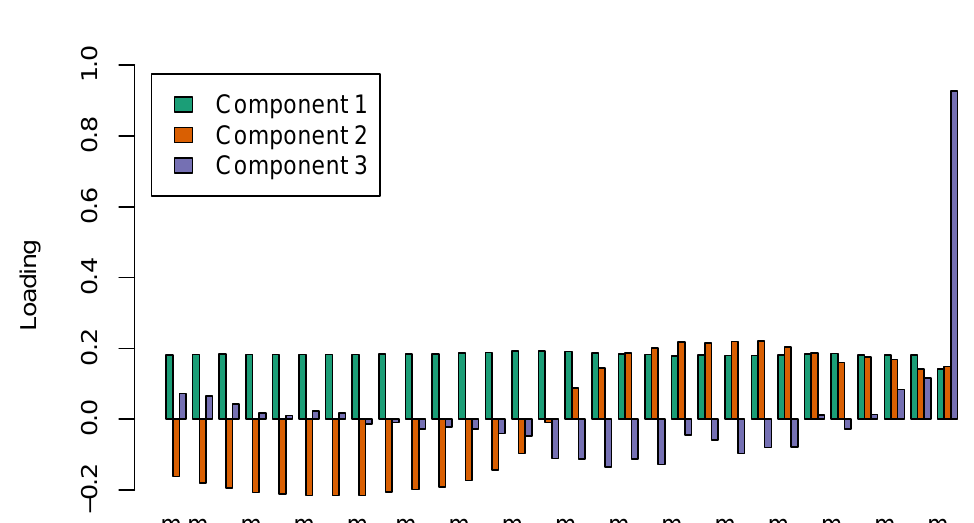
Figure 6. Loadings of the first three principal components of the Fourier median variables ( m to m 1 30